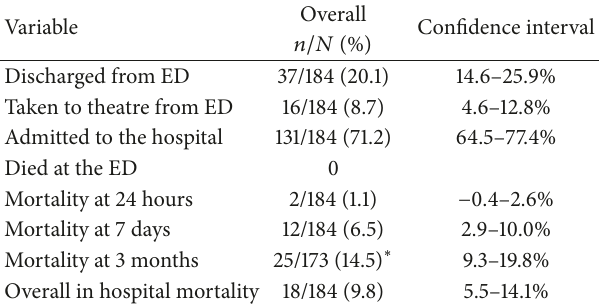
Table 4: ED disposition and